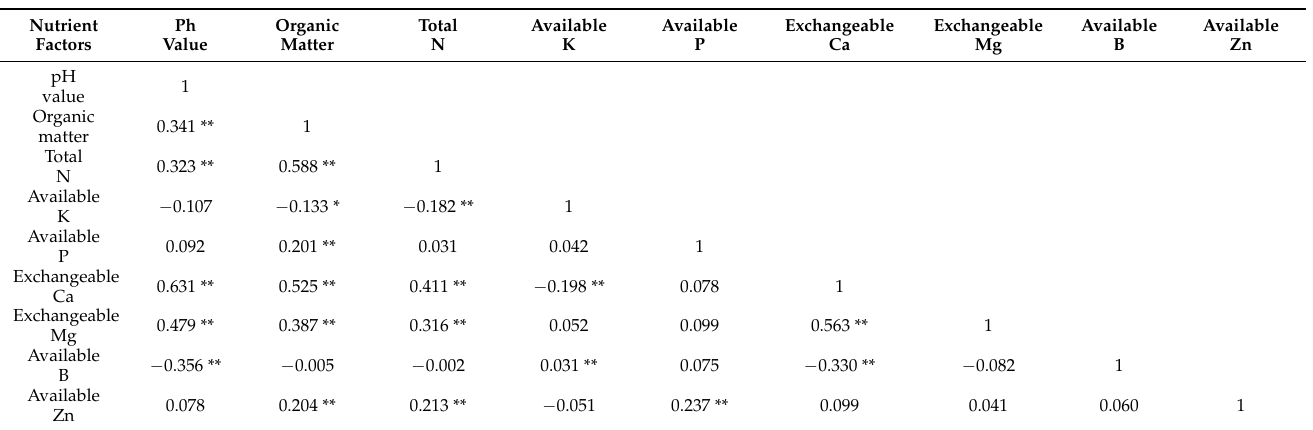
Table 4. Correlation analysis of tobacco planting soil.